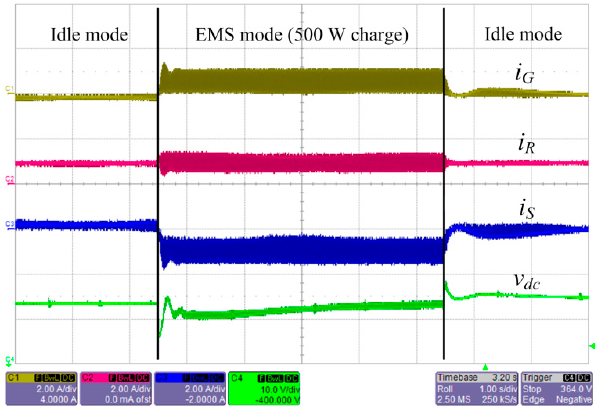
Figure 15. State transition of SC between idle mode and EMS mode.